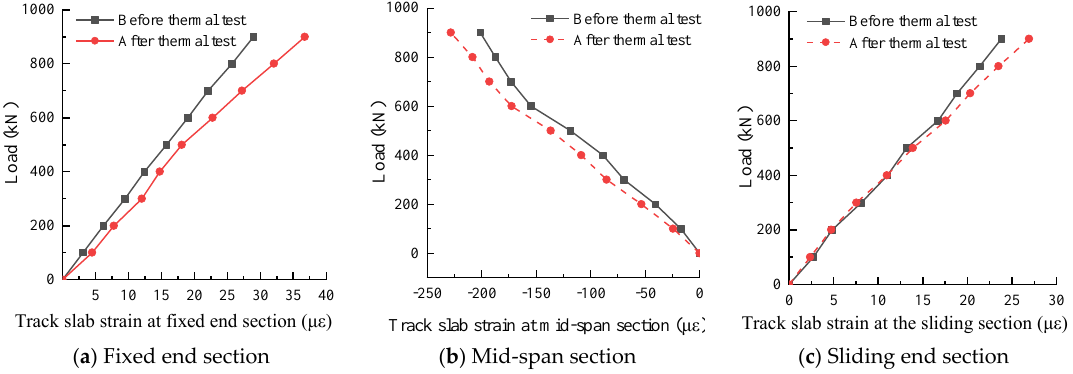
Figure 20. Load–strain curve of the track slab under static load.